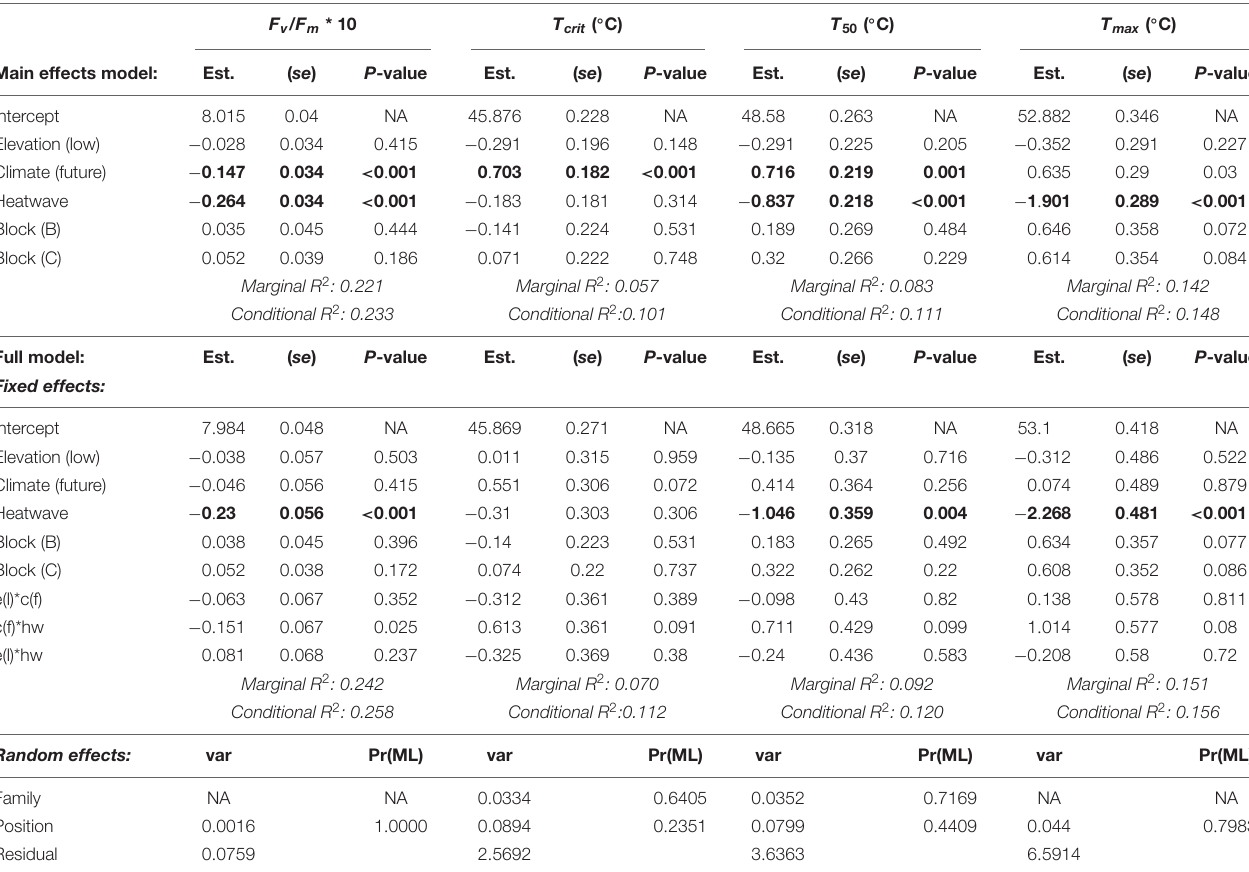
TABLE 1 | Effects of temperature treatments on thermal physiology traits: results from linear random intercept